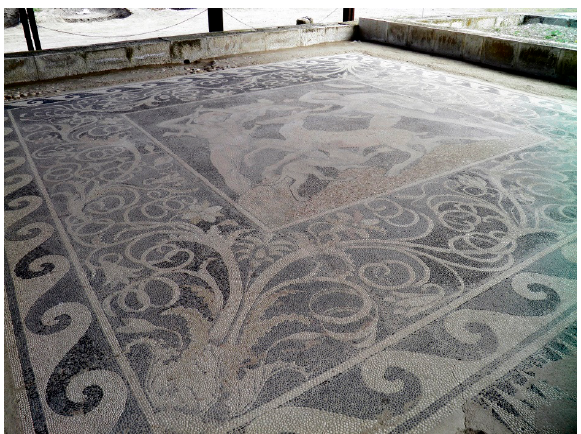
Figure 8. Taranto, Museo Archeologico Nazionale inv. 54114 Gold diadem decorated with floral tendrils and acanthus calyx from Crispiano, Contrada Cacciavillani, first half 4th century B.C. Author’s photo.